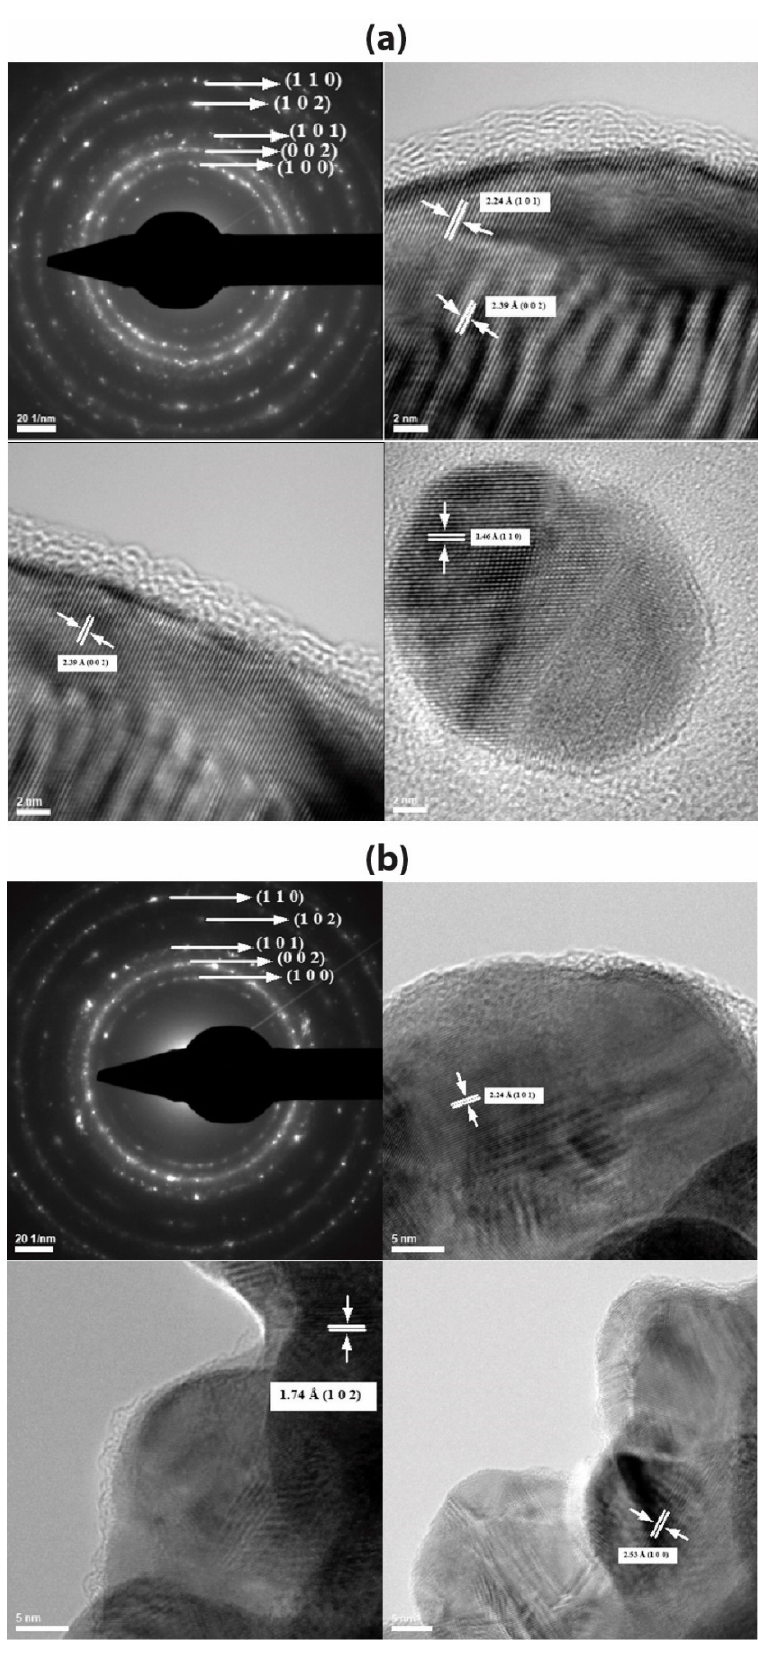
Figure 1. images recorded for ( a ) EG-AgNPs and ( b ) PVP-EG-AgNPs.